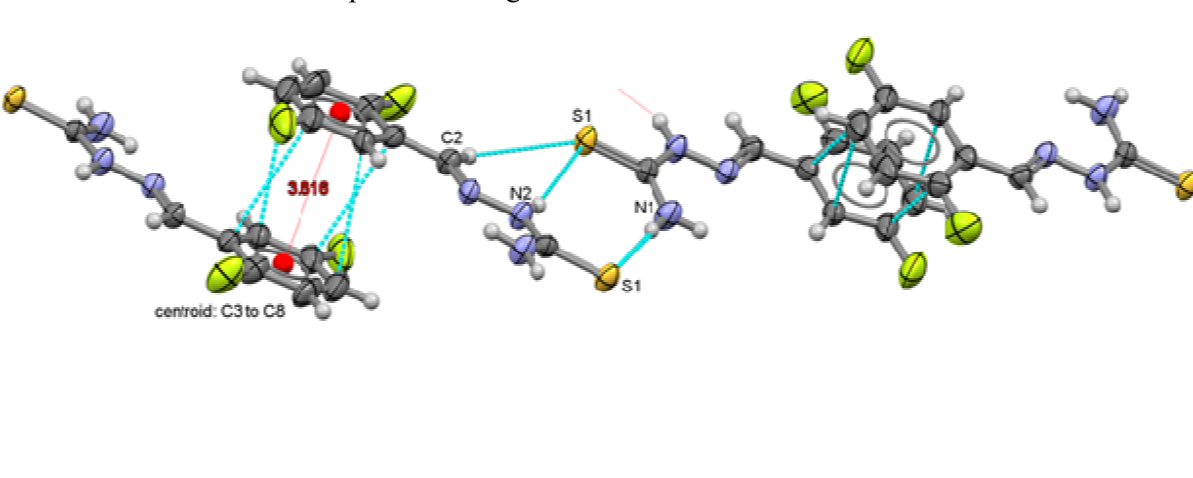
( 2 ) showing the π 2